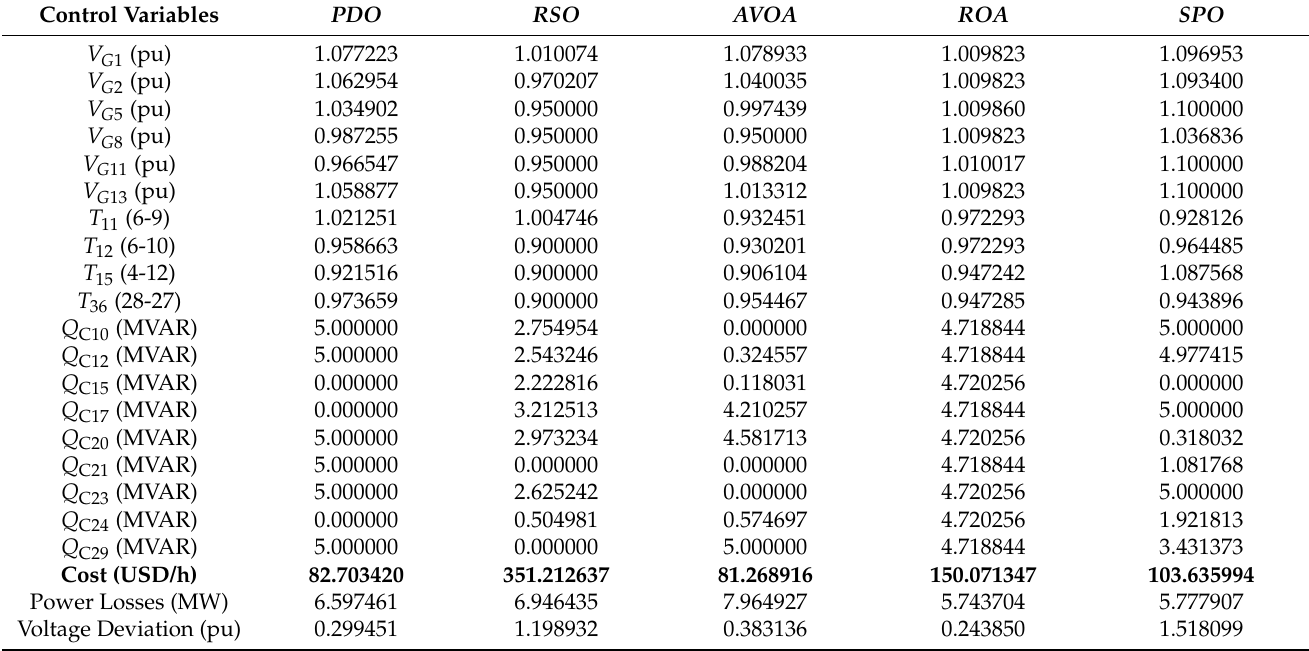
Table 10. Balance of active and reactive power for proposed algorithms with case 2.